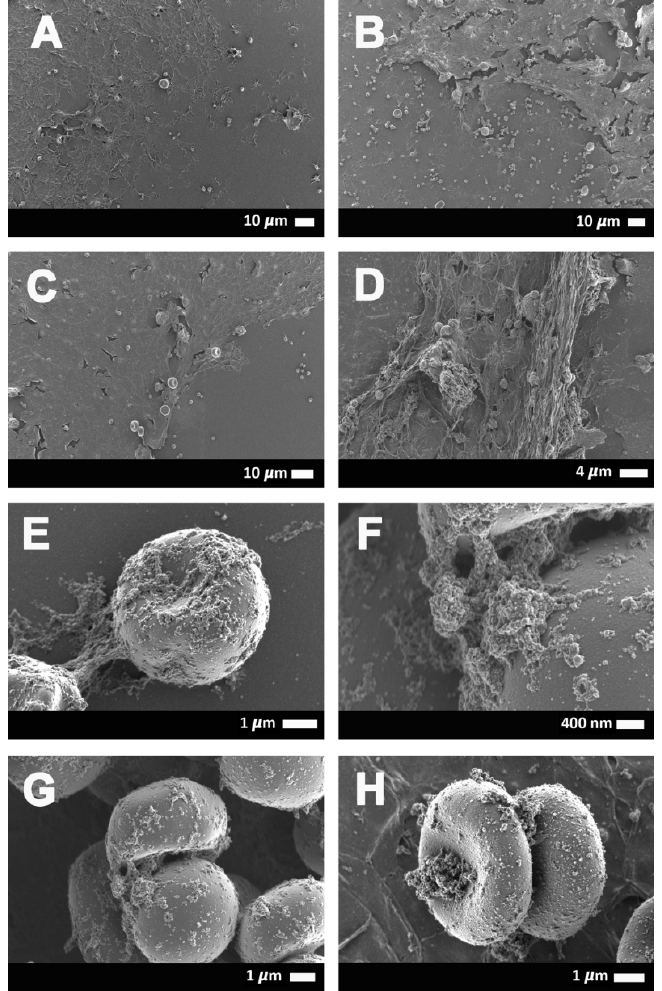
Figure 6. ( A – D ) Representative scanning electron micrographs of COVID-19-positive samples with spontaneous fiber-like clotlet formations in close proximity to erythrocytes in whole-blood smears, as well as occasional granular deposits ( E – H ) on the erythrocytes.